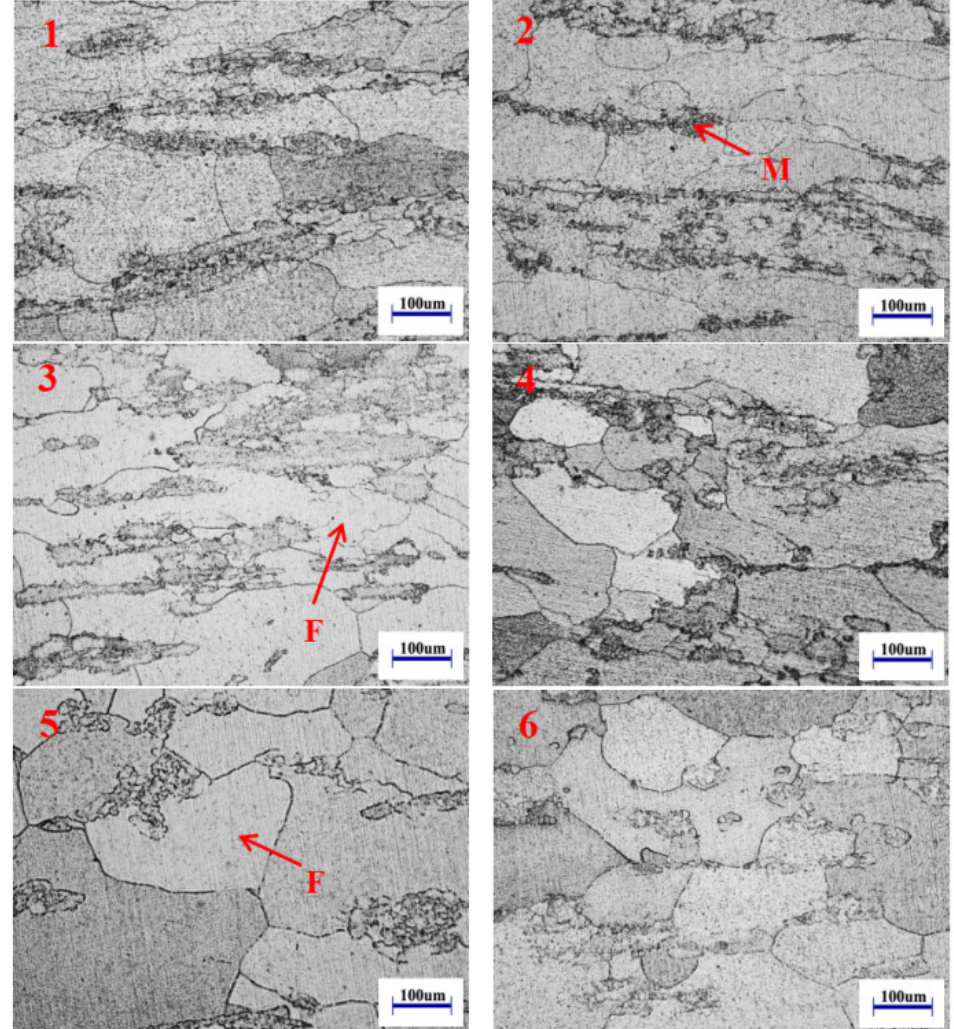
Figure 15. Microstructure of base metal zone at different holding times: ( 1 ) 30 s, ( 2 ) 2 min, ( 3 ) 5 min, ( 4 ) 15 min, ( 5 ) 1 h, ( 6 ) Complete recrystallization (CR) .